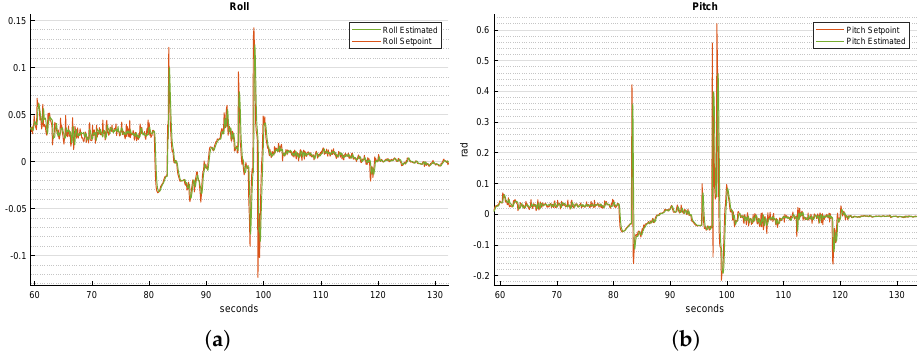
Figure 7. Time-wise behavior of the desired and estimated roll ( a ) and pitch ( b ) of the UAV during the landing